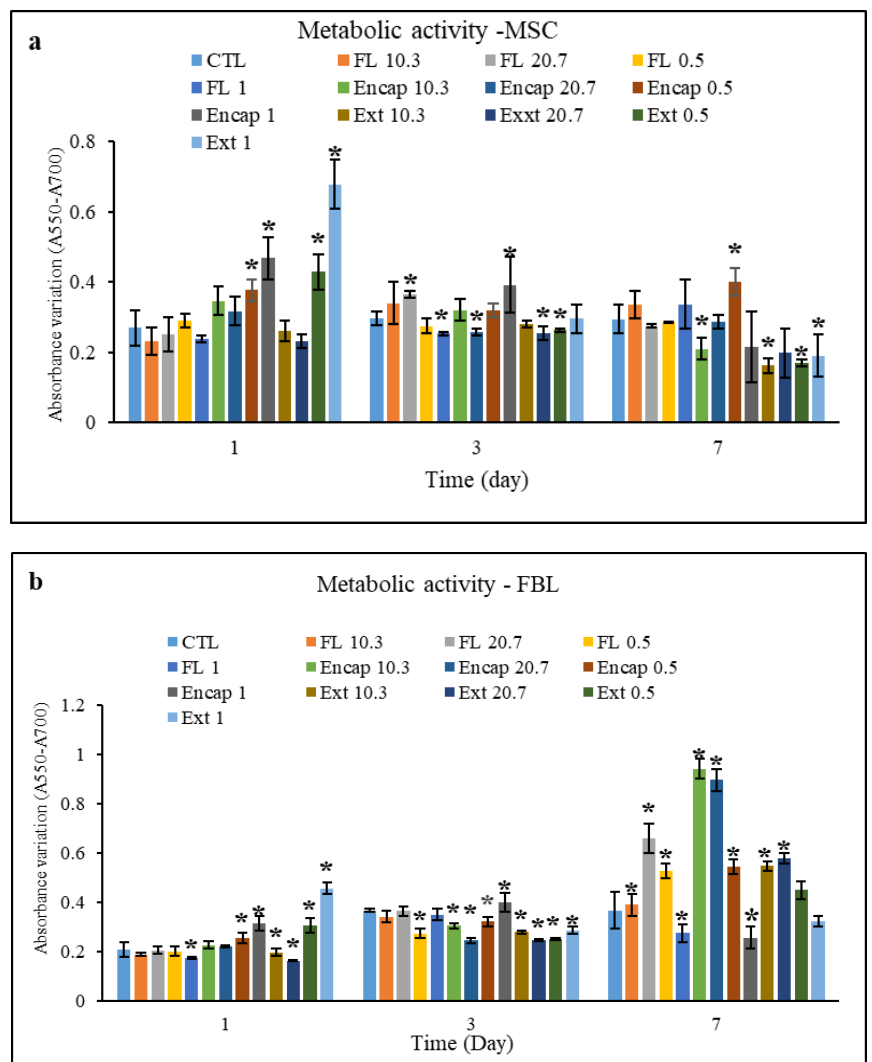
Figure 4. Metabolic activity of human cells: ( a )—MSC cells, ( b )—FBL cells under different treatments by: AC extract (Ext), unloaded nanoliposomes (FL) and AC-loaded nanoliposomes (Encap). CTL is control sample including unstimulated cells. Indexes of 1, 0.5, 20.7 and 10.3 represent the concentration of different treatments as 1 mg.mL − 1 , 0.5 mg.mL − 1 , 20.7 µ g.mL − 1 , and 10.4 µ g.mL − 1 respectively. * indicates there is significant statistical difference between different treatments and control sample ( p < 0.05). The results are mean of three replications ±